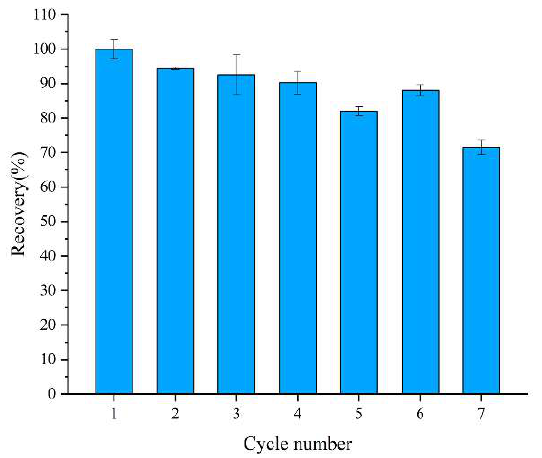
Figure 4. Recyclability of encapsulated glucose oxidase.